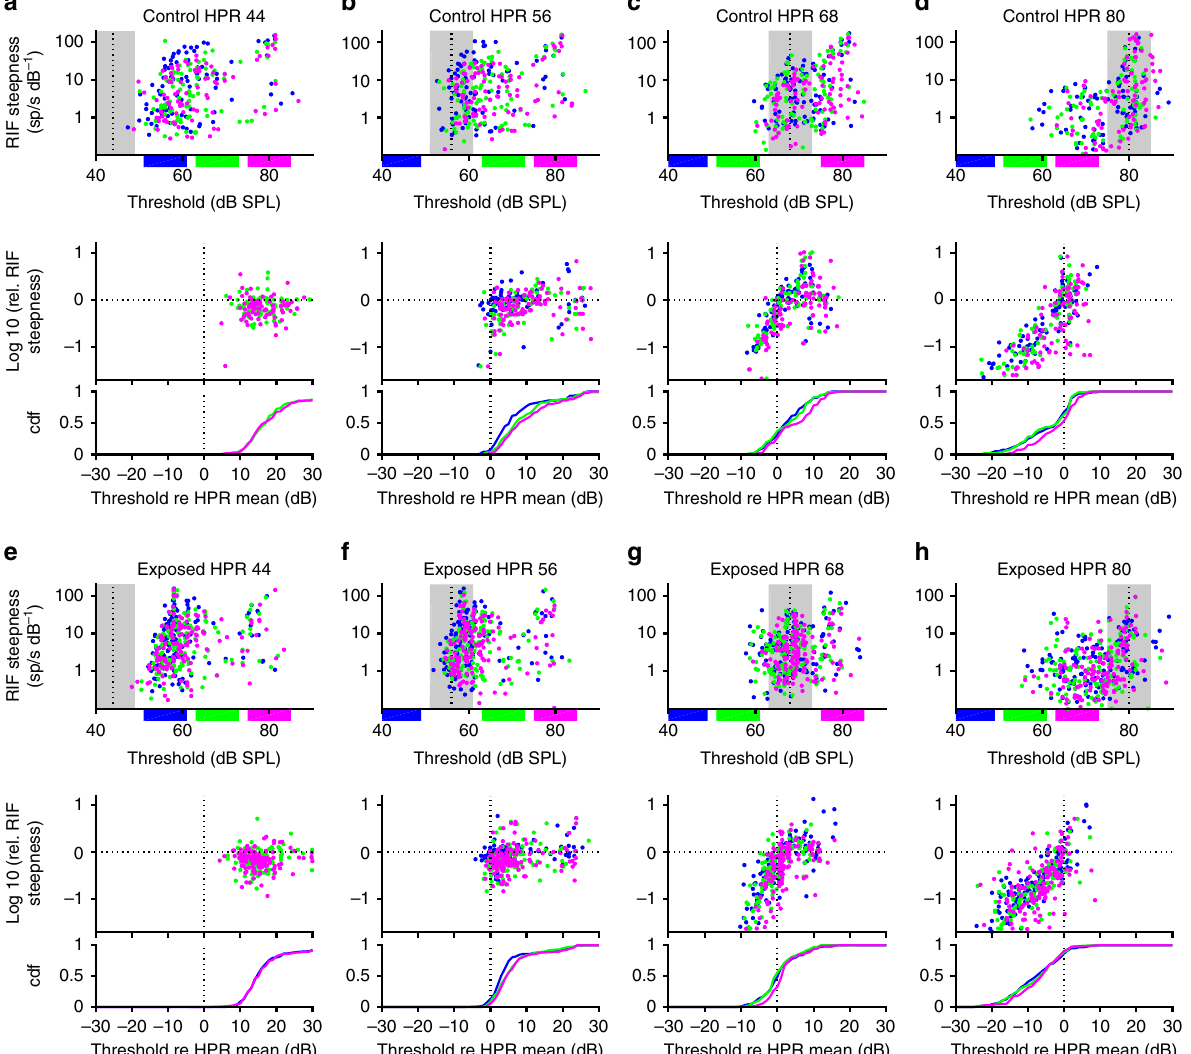
Fig. 6 Interplay between threshold and gain adaptation. a – d MUCs from control animals had the highest RIF steepness when the adapted threshold was towards the upper edge or above the HPR (top row, the colours denote the intensity of the HPR during the other half of the switching stimulus, see Fig. 4) Within-unit analysis of gain changes relative to the RIF steepness for the 44 (56) HPR (middle row) demonstrated that RIF steepness is reduced when the adapted threshold falls below the HPR mean. The cumulative distribution of MUC thresholds is shown in the bottom row. e – h MUCs from exposed animals also showed a tendency towards steeper RLFs with higher adapted thresholds, but there were much fewer units with thresholds above the HPR range for loud HPRs (bottom row). For the 80 dB HPRs, most MUCs showed a decrease in RIF steepness relative to the RIFs in response to the 44 (56)